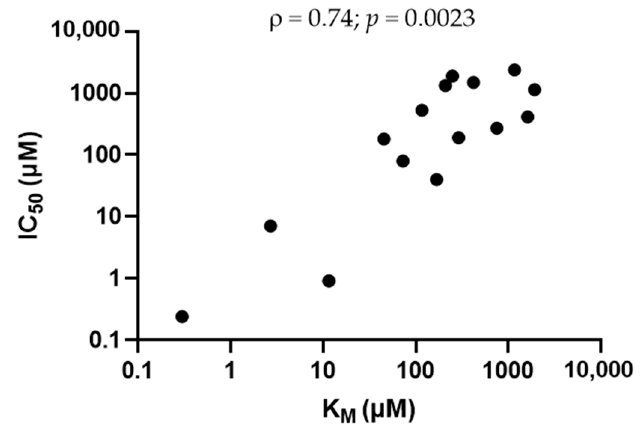
Figure 3. Spearman’s rank correlation between Michaelis constant (K M ) and IC 50 values for OCT2 substrates ( n = 15). Spearman ρ coefficient and p value are indicated on the top of graph. K M were from Table 1; K M means were used for compounds for which various K M have been reported.